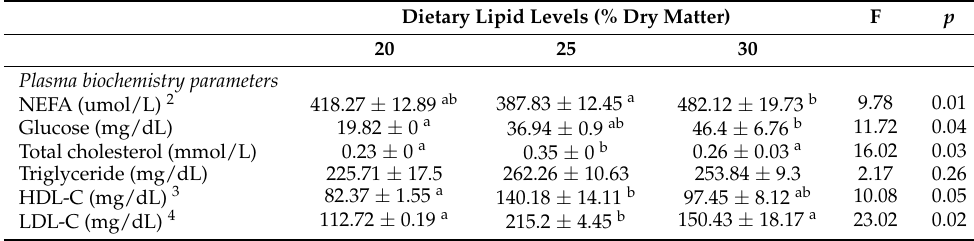
Table 4. Plasma biochemical parameters of triploid rainbow trout fed the experimental diets for 77 days 1 .